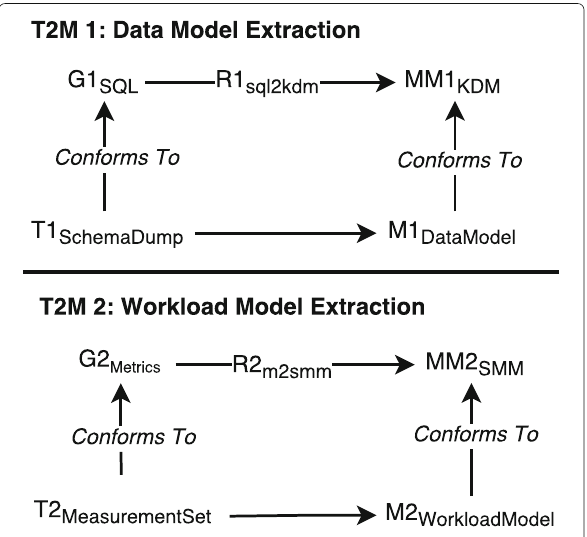
Fig. 2 Text-to-model transformations in